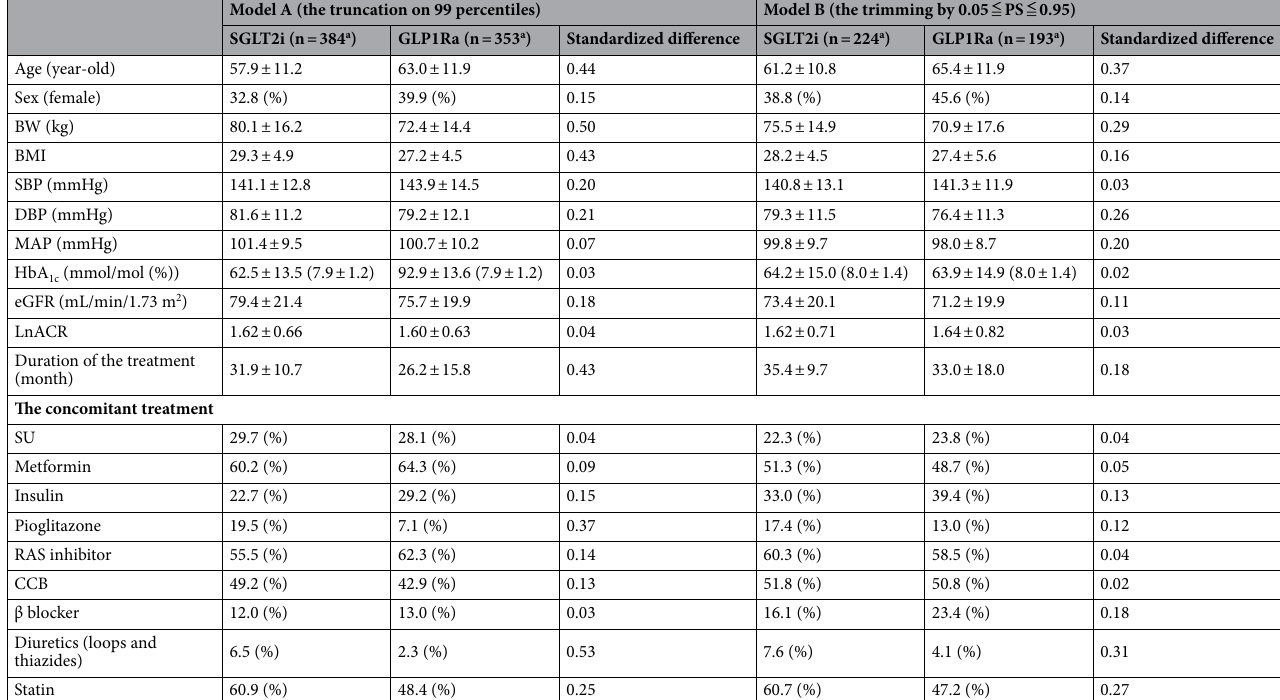
Table 3. The clinical characteristics of SGLT2i-treated and GLP1Ra-treated patients after ATT weighting. Values represent the mean ± standard difference, or n (n/total %). a Calculated number of participants